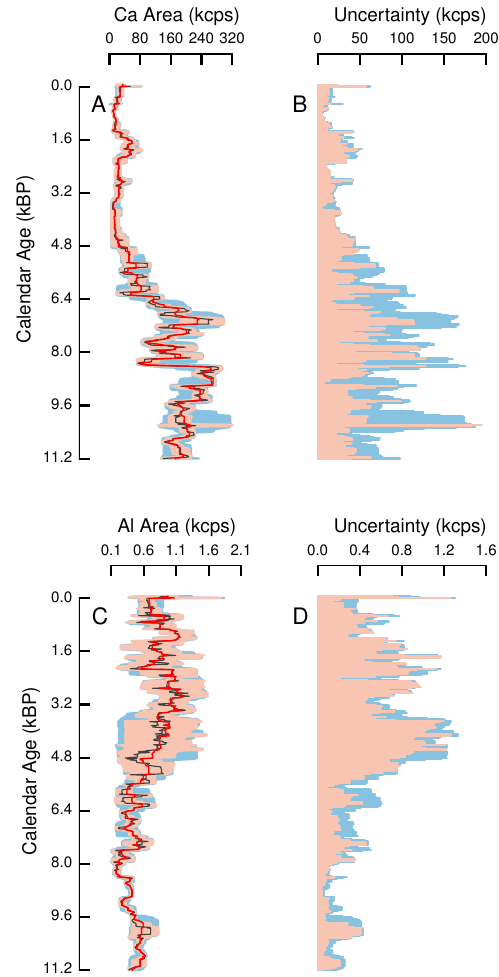
Figure 10. Contribution of age uncertainty to proxy estimation un- certainty. (a, c) The proxy records for Ca area (in a ) and Al area (in Fig. 10. Contribution of age uncertainty to proxy estimation uncer- c ) for the original set of observations (red curves for the median, tainty. A, C. The proxy records for Ca-area (in A ) and Al-area (in C ) light blue area for 95% confidence bands) along with the proxy for the original set of observations (red curves for the median, light records after making the RM age model uncertainty identical to blue area for 95% confidence bands) along with the proxy records zero (dark gray curves for the median, orange area for 95% con- after setting the RM age model uncertainty identically to zero (dark fidence bands). (b, d) The uncertainties for each time point (95% gray curves for the median, orange area for 95% confidence bands). B, D. The uncertainties for each time point (95% confidence bands confidence bands shown in a and c ) and for the two cases: original shown in A and C) and for the two cases: original observations (light observations (light blue), and after setting the RM age model error blue); and after setting RM age model error to zero (orange). (Color to zero (orange). (Color online.)